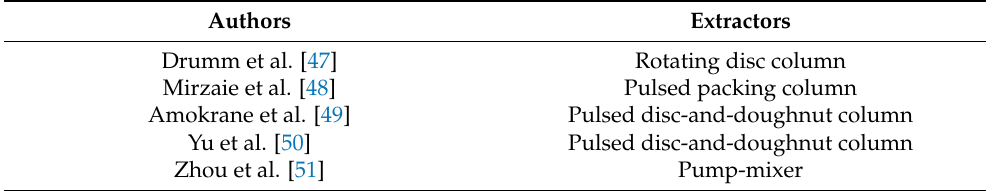
Table 3. Studies on CFD-PBM